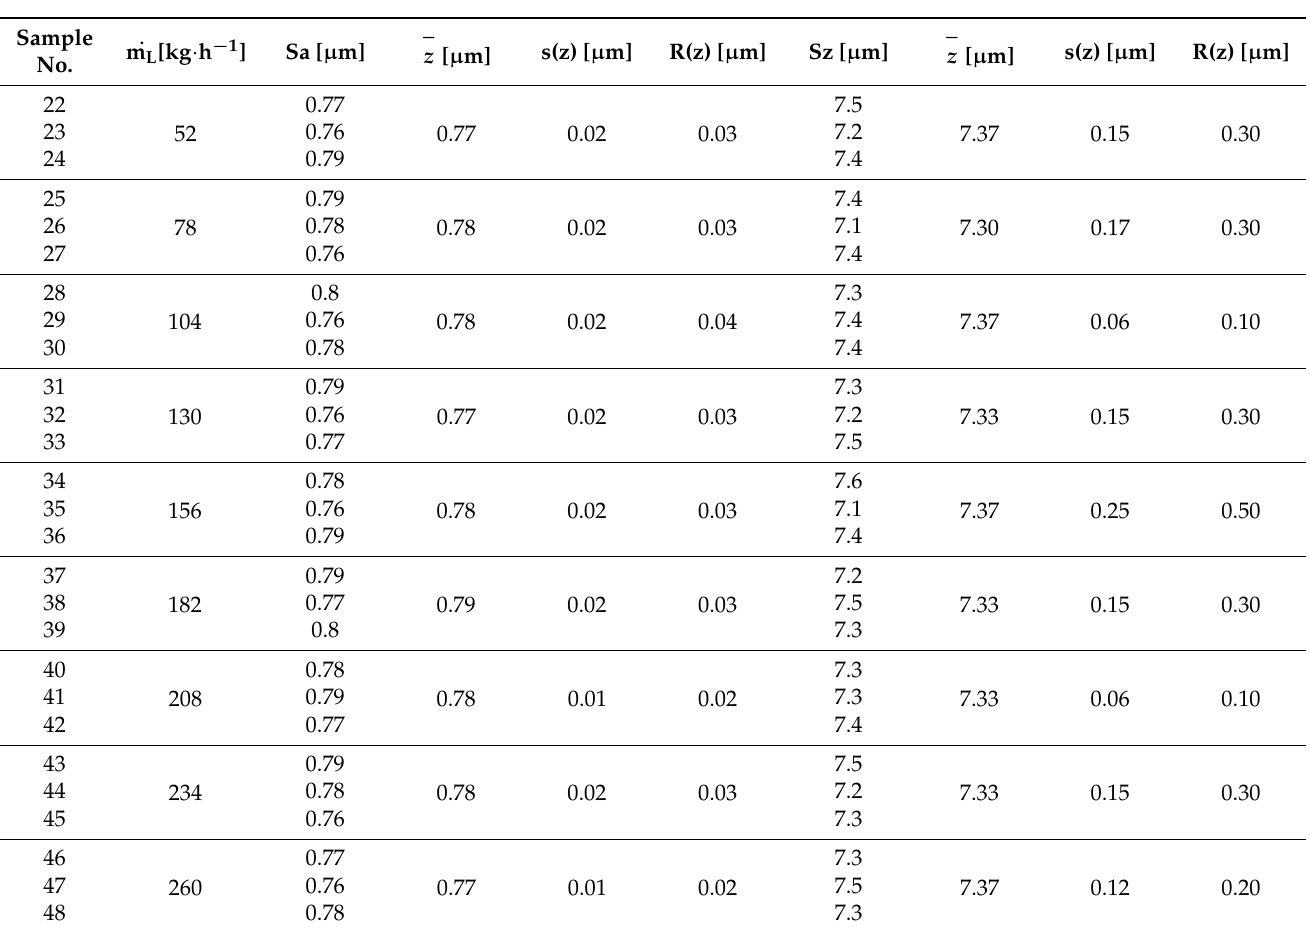
Table 6. Results of Sa and Sz measurements of X5CrNi18-10 steel specimens after removal of paint coating (p w = 35 MPa, l 2 = 250 mm, κ = 90 ◦